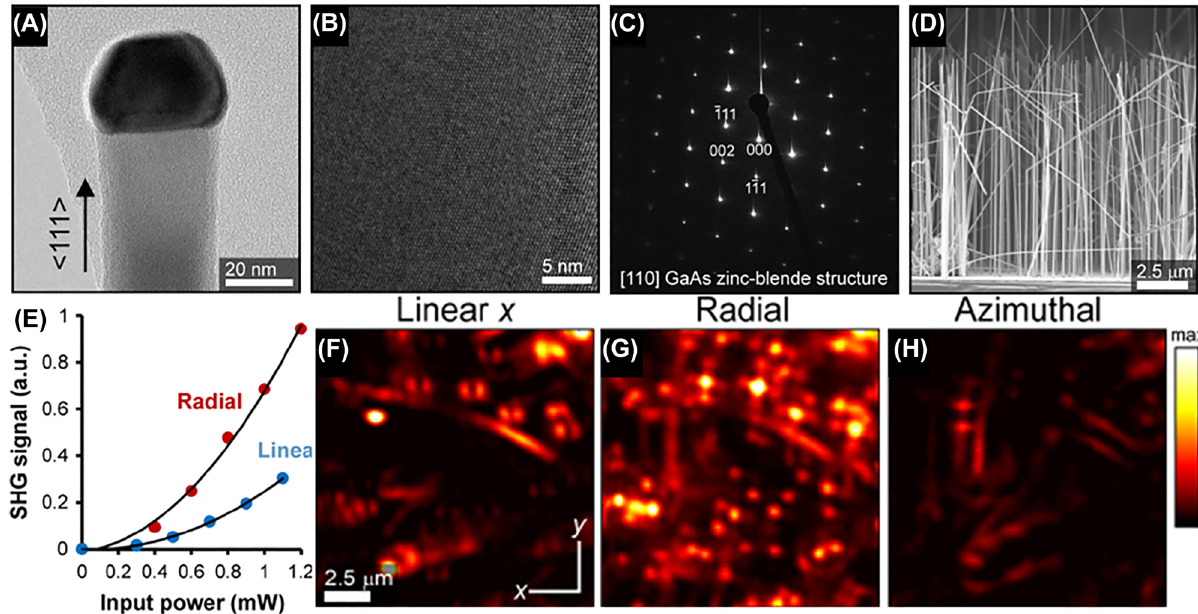
Figure 9: Second-harmonic generation images of GaAs nanowires excited by CVB. (A, B) TEM characterizing results of a GaAs nanowire grown on a GaAs substrate. (C) Typical indexed ED pattern taken at different sections along the nanowire axis. (D) SEM image of the GaAs nanowires used in the SHG imaging (side view). (E) Power dependence of the SHG signal from an individual GaAs nanowire using focused RP and LP. (F) Far-field SHG images of vertically aligned GaAs nanowires (diameter = 40 nm, length = 10 μ m) illuminated by LP along x direction. (G) Far-field SHG images illuminated by RP under the same experiment settings with (F). (H) Far-field SHG images illuminated by AP under the same experiment settings with (F). Adapted from Ref. [154]. Copyright 2015 American Chemical